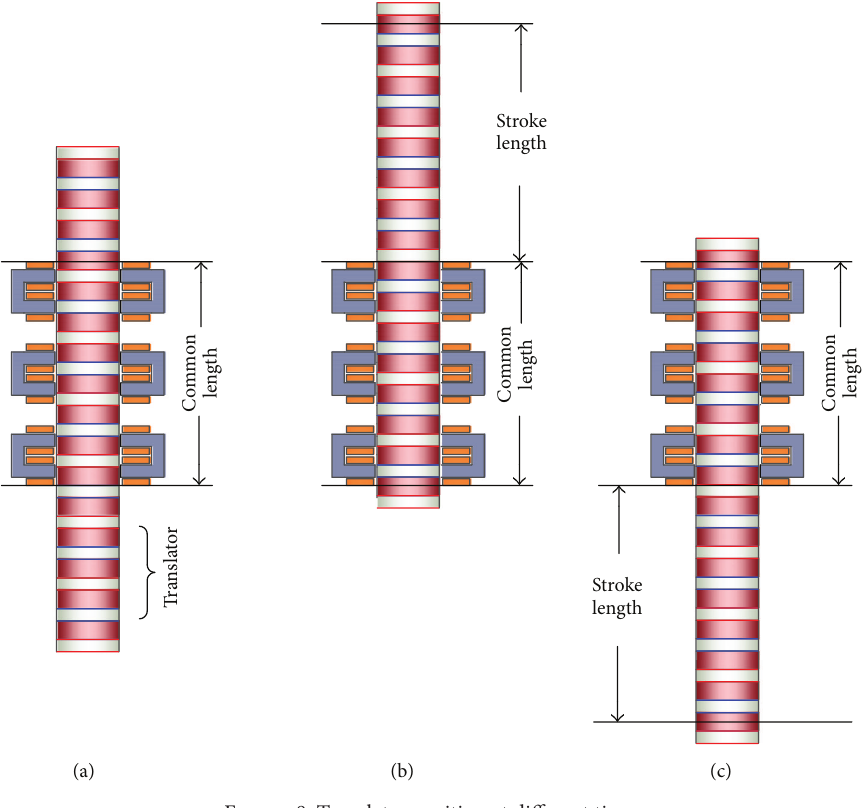
Figure 8: Translator position at different time.